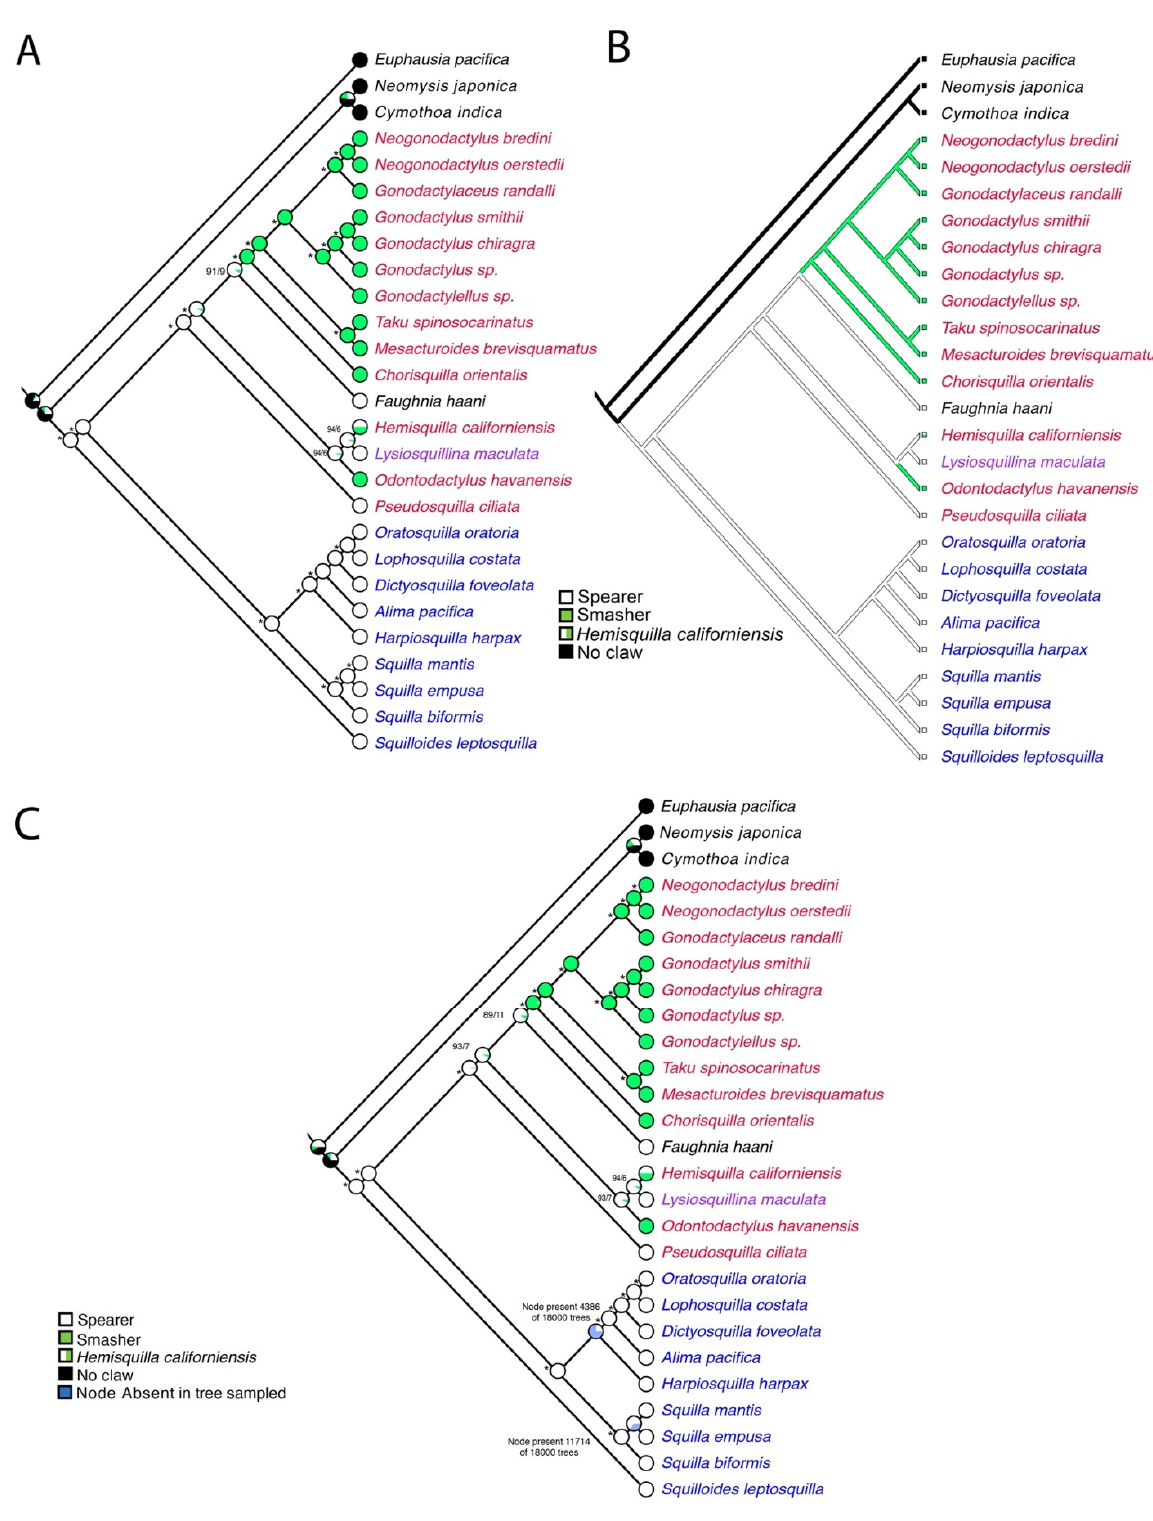
Figure 6 . Ancestral state reconstruction, using Mesquite, of the raptorial claws mapped onto the Eumalocostraca outgroup maximum likelihood tree for the EumalAA dataset. ( A ) Maximum likelihood reconstruction. Asterisks represent nodes with proportional likelihood estimations of >95%. Other scores for the ingroup are provided in order of most likely states and separated with a forward slash. ( B ) The single most parsimonious reconstruction for this topology. Coloring of terminal names as in Figures 2 and 3. Hemisquilla californiensis was coded as either spearer or smasher. ( C ) ‘Trace Character Over Trees’ summary of ancestral state reconstructions over 18,000 post-burnin trees from the EumalAA BI analysis, traced under the Mk1 probability model on the EumalAA ML tree topology.